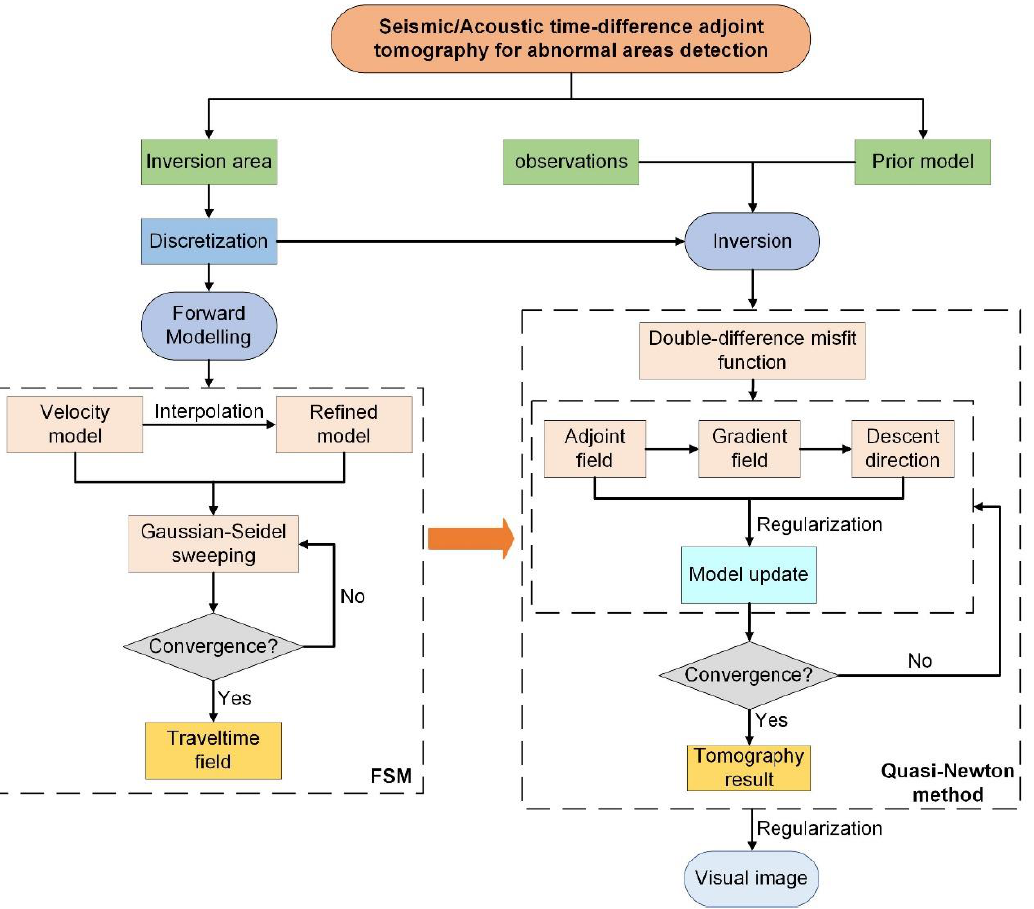
Figure 1. Workflow of time-difference adjoint tomography (TDAT). FSM: fast sweeping method.